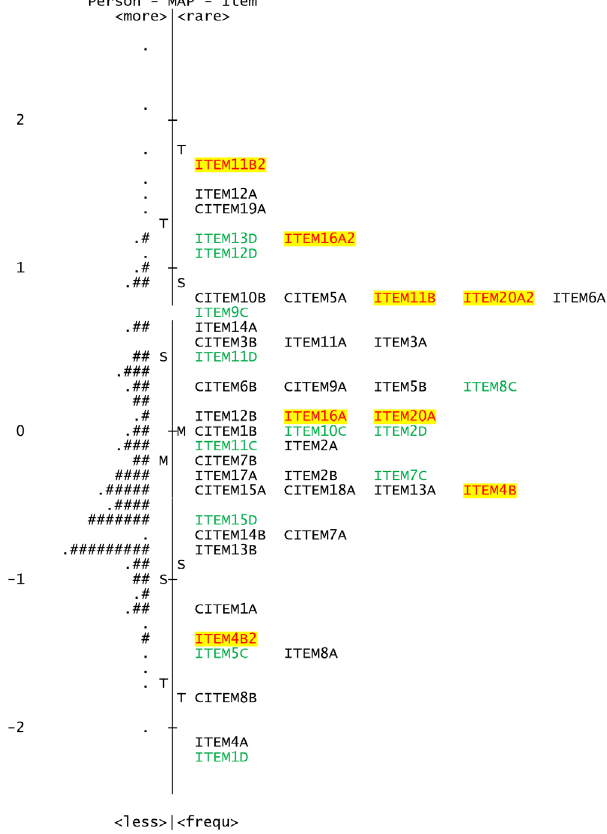
FIG. 3. Wright map for the combined analysis. Common items ’ labels begin with the letter “ C. ” New items are green and four items that were dropped from the linking set are shown in yellow. For example, the label “ Item 16A ” describes the functioning of Item 16A in the initial study and “ Item 16A2 ” describes the functioning of the same item in the depositing